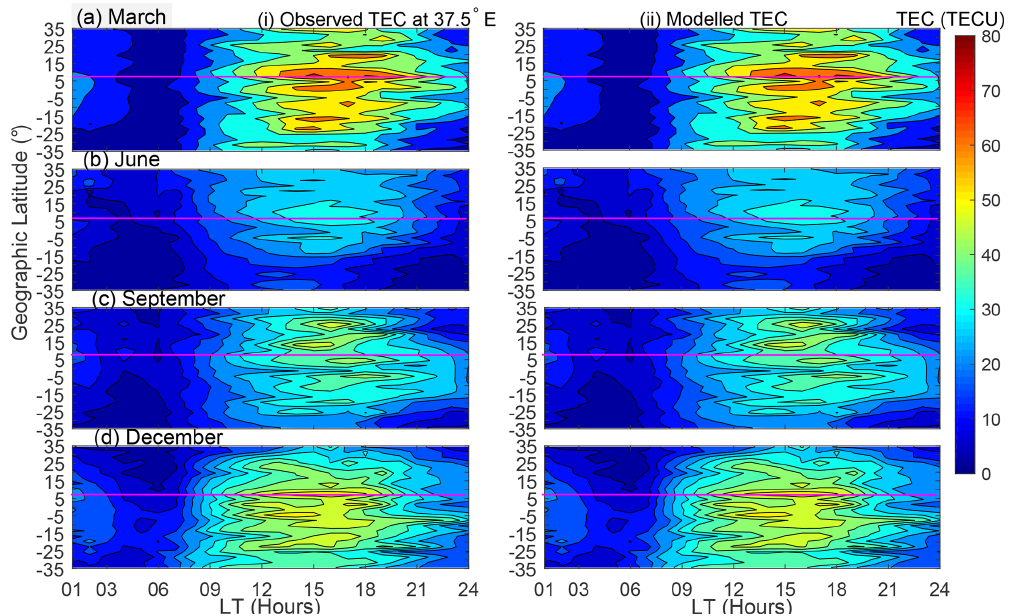
Figure 3. Variation of TEC as a function of latitude and local time in HSA at 37.5 ◦ E. Panels in rows (a–d) are for the March equinox, June solstice, September equinox, and December solstice, respectively, while panels in columns (i) and (ii) are observed binned and modeled TEC, respectively. The magenta line indicates 0 ◦ dip latitude.